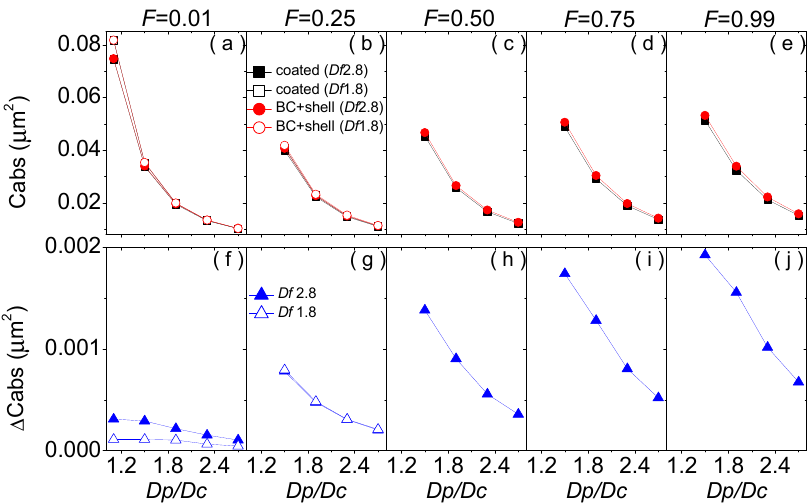
Figure 2. The absorption cross sections of BC partially coated by organics with an absorbing volume fraction of coating of 0.5 as a function of shell/core ratio ( Dp / Dc ) at 550 nm. The sums of absorption cross sections of absorbing coating and BC with a non-absorbing coating are compared to the absorptions of partially coated BC (top row), and their absorption differences are also shown (bottom row). Five coated volume fractions of BC ( F ) being 0.01, 0.25, 0.5, 0.75 and 0.99 are shown from left to right. Open and solid symbols denote BC fractal dimensions of 1.8 and 2.8, respectively. Black squares indicate the absorptions of partially coated BC with a coating absorbing volume fraction of 0.5. Red circles indicate the sums of the absorptions of absorbing coating and BC with a related non-absorbing coating. Blue triangles represent their absorption differences.